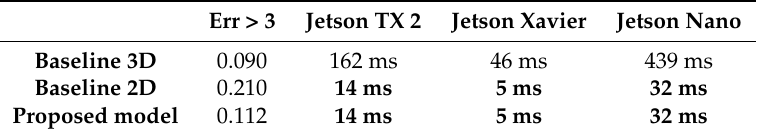
Table 7. Final results of our proposed model. All models were optimized using TensorRT and using the custom CUDA kernel from Algorithm 1. Baseline 3D is the model from Figure 2 (top) but using a sequence of 3D convolutions for the cost-volume postprocessing. Baseline 2D is similar to baseline 3D but using 2D convolutions instead of 3D convolutions (naive approach). In black real-time performance; lower is better. The disparity error (Err > 3) for each model is the same in all devices. All models are optimized as in Section 5.